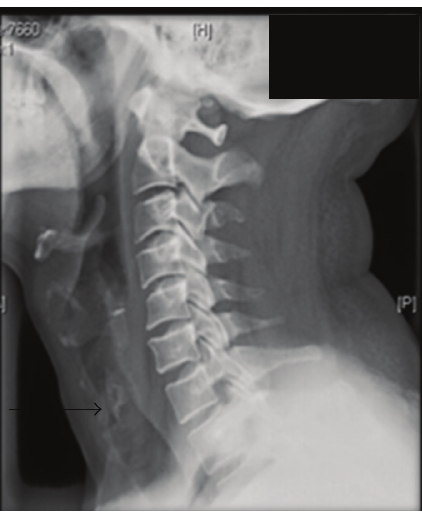
Figure 1: X-ray neck lateral view—radiopaque foreign body at C6- C7